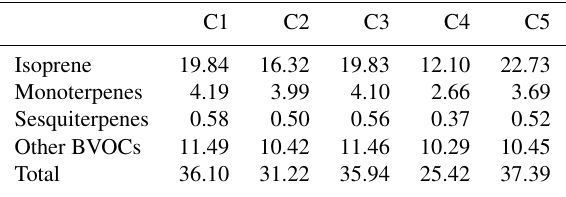
Table 2. Estimated BVOC emissions (Tg) in different cases across